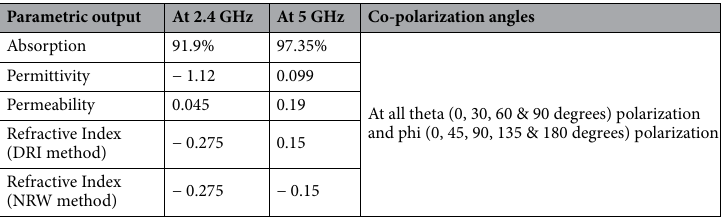
Table 1. Parameter values from cst simulation at the resonance frequencies for all co-polarization angles.